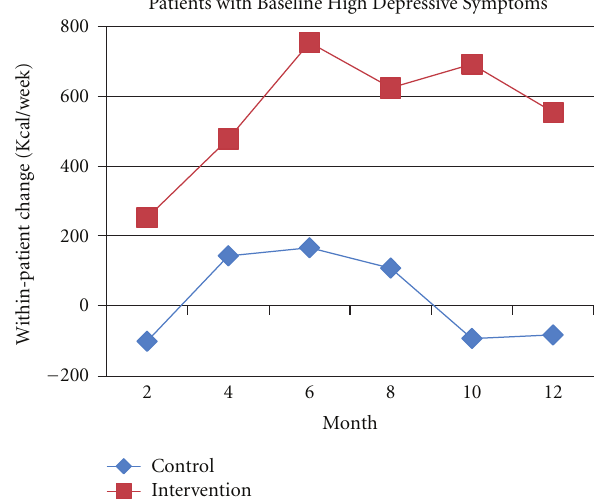
Figure 3: Physical activity expenditure over 12 months in the positive a ff ect intervention versus control group among patients with high depressive symptoms at baseline ∗ P = 0 . 038 at 12 months.